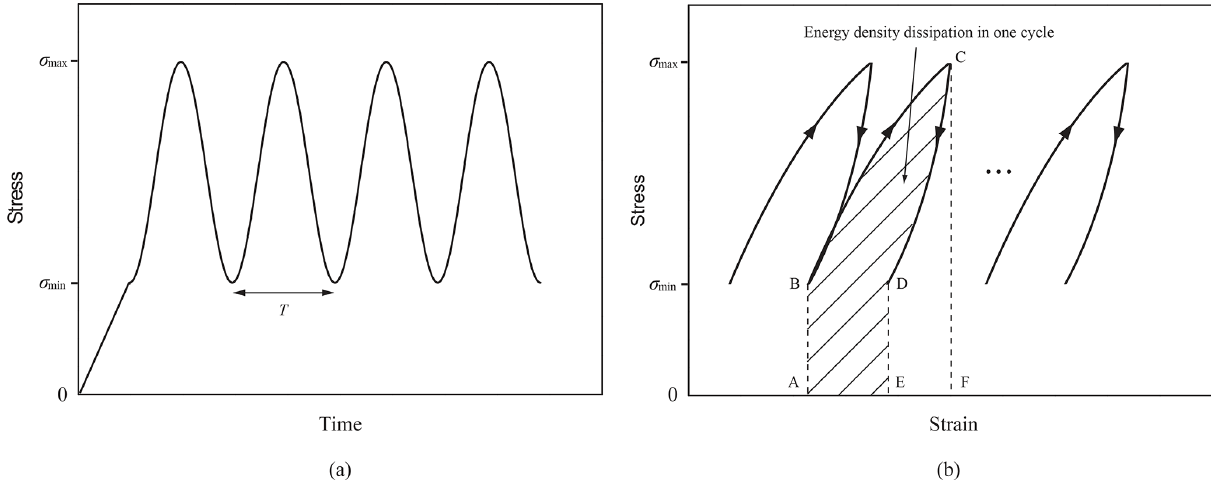
Figure 7. Schematic diagrams of the cyclic loads: (a) the inputted stress waveform and (b) the method for calculating the energy density dissipated in one loading cycle (in other words, region ABCDE).